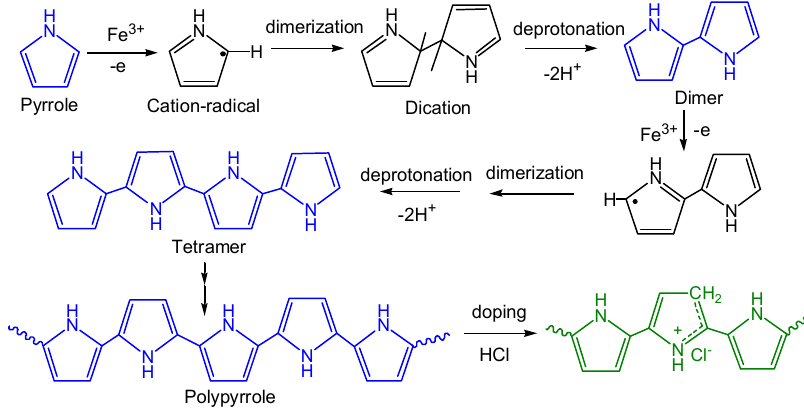
Figure 2. Schematic diagram of the polypyrrole formation mechanism.